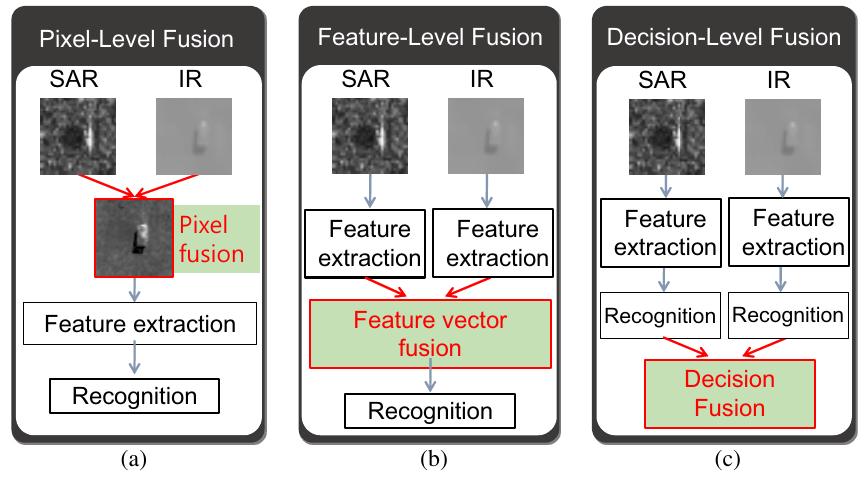
Figure 1. SAR and IR sensor fusion-based target recognition schemes: ( a ) pixel-level fusion; ( b ) feature-level fusion; and ( c ) decision-level